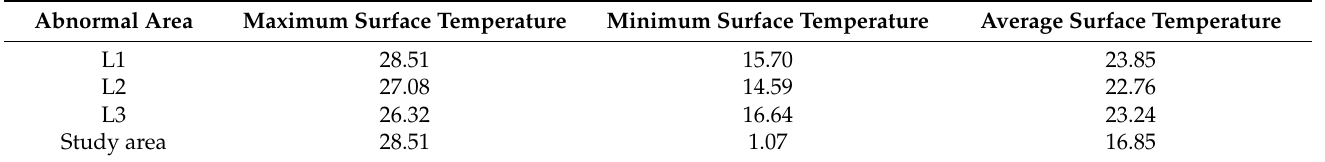
Table 6. Correlations between thermal anomalies and radioactive elements.